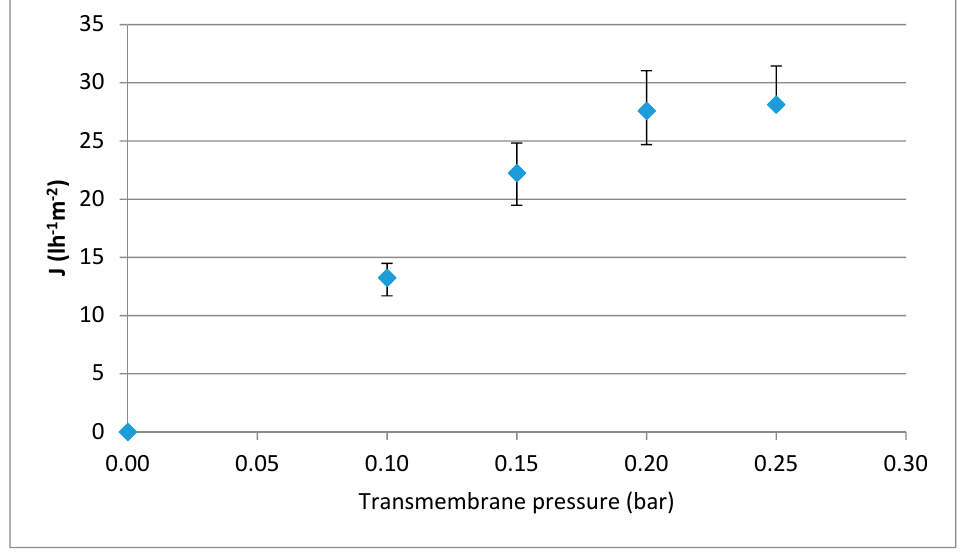
Figure 2. Determination of the optimal transmembrane pressure.